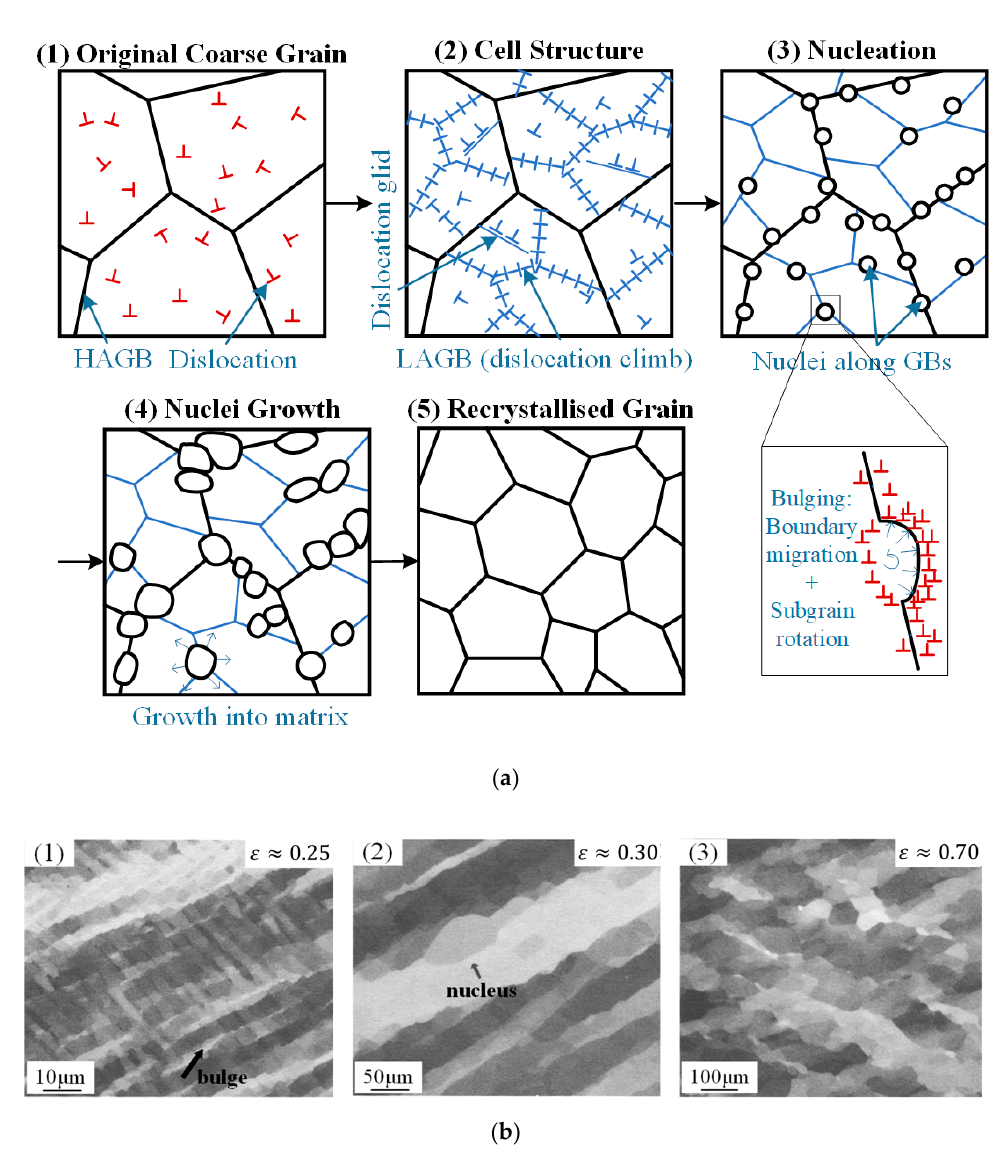
Figure 1. Development of new grains during DDRX: ( a ) schematic illustration, ( b ) experimental observation of as-annealed pure Al (99.999%) compressed at 350 °C and 1.11 × 10 − 2 s − 1 (Reproduced with permission from Elsevier [24]).